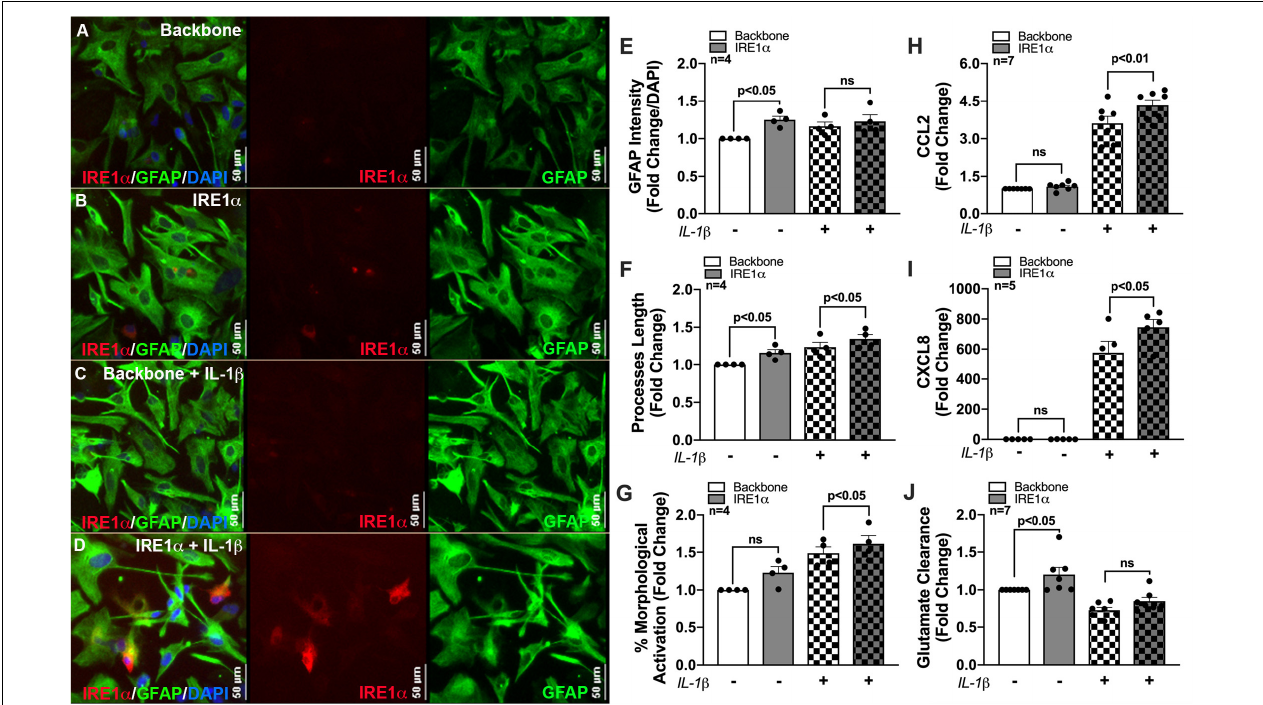
FIGURE 7 | IRE1 α overexpression augments cytokine expression and increases glutamate clearance in human astrocytes. Backbone and IRE1 α transfected astrocytes were treated with IL-1 β for 24 h. (A–D) Cells were immunolabeled with antibodies specific for IRE1 α (red) and the astrocyte marker glial fibrillary acidic protein (GFAP, green). Nuclear DNA was labeled with DAPI (blue). (E–G) Experiments in four separate biological donors were analyzed to quantify morphological activation. Individual dots on graphs represent compiled fold-changes calculated from duplicate wells and/or triplicate images per condition for each biological astrocyte donor. (E) GFAP intensity was measured across full-well scans using SoftMax Pro and normalized to DAPI. (F) Process length of individual astrocytes was manually traced and measured using ImageJ Software. (G) Percent morphological activation was calculated based on the number of astrocytes presenting with ‘reactive’ morphology divided by the total number of astrocytes imaged. (H) CCL2 and (I) CXCL8 levels were assessed by an ELISA, and expression was normalized to metabolic activity prior to calculating fold changes to backbone. (J) Astrocytes were treated with 400 nM glutamate for 24 h. Remaining glutamate levels were quantified by fluorescent assay to calculate% glutamate clearance followed by fold change for each individual donor. Individual dots on graphs represent compiled data from triplicate experiments per biological astrocyte donor. Significance was determined by one-way ANOVA and Tukey’s post hoc for multiple